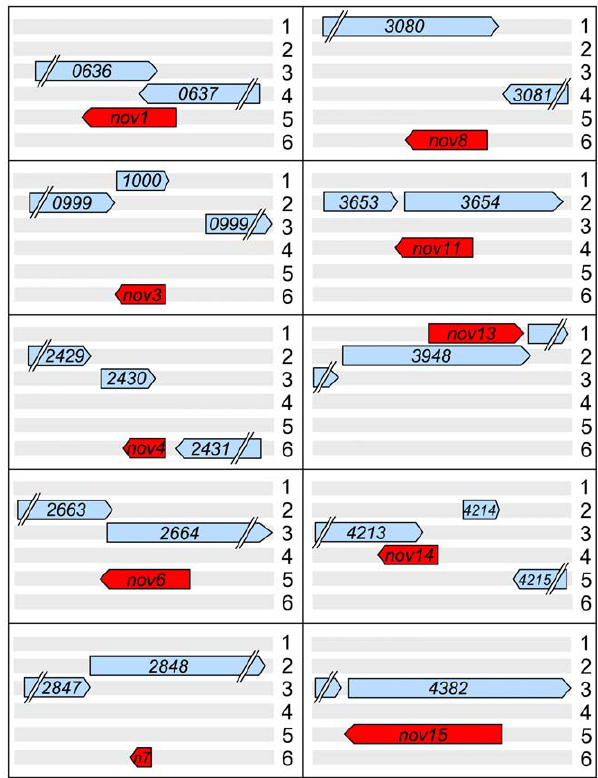
Figure 1. Organization of ten novel ORFs overlapping predict- ed genes in P.fluorescens Pf0-1. The novel ORFs are colored red and indicated by ‘‘ nov ’’ (or n7 for nov7 ), while predicted Pf0-1 genes are colored blue and labeled with the Pfl01 number of the locus tag corresponding to each in the Pf0-1 GenBank entry. Three forward (numbered 1-3) and three reverse (numbered 4–6) reading frames are shown. Parallel diagonal lines indicate that the complete ORF is not shown to scale. For the length of predicted nov- encoded proteins, see Table 1.